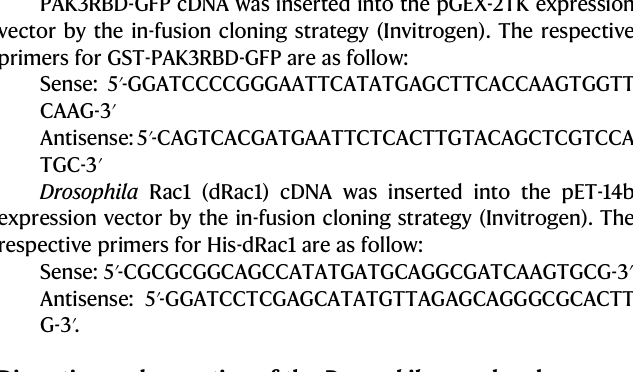
before and after photo-activation of PA-Cdc42 at leader border cell protrusions. Dotted blue circle labelling the PA regions with blue light illumination. PA means photo-activation. RGB colours marking the trajectory of border cell migration. g Time-lapse quanti fi cations of mean migration speed ( μ m per minute) in the bordercellgroupsexpressingeitherPA-Cdc42T17NorPA-Cdc42Q61L,afterphoto- activation of PA-Cdc42 at leader border cell protrusions, compared with photo- treated WT border cell groups. Scale bars are 2 μ m in ( a ), and 10 μ m in ( e ) and ( f ). Boxplot shows medians, 25th and 75th percentiles as box limits, minimum and maximum values as whiskers; each datapoint is displayed as a dot (from n biolo- gically independent samples for each border cell group) in ( b – d ). Data are pre- sented as mean values± SD in ( g ) (from n biologically independent samples for eachbordercellgroup). P valuesbytwo-sidedMann – Whitneytesthavebeenlisted in Supplementary Note 1. Source data are provided as a Source Data fi